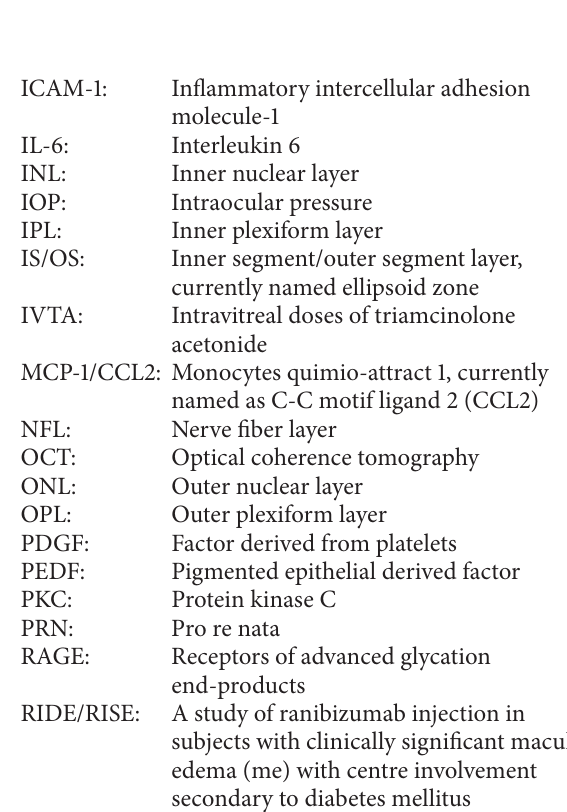
Figure 9: OCT angiography of a patient. (a) Superficial plexus, (b) inner plexus, and (c) optical coherence tomography.